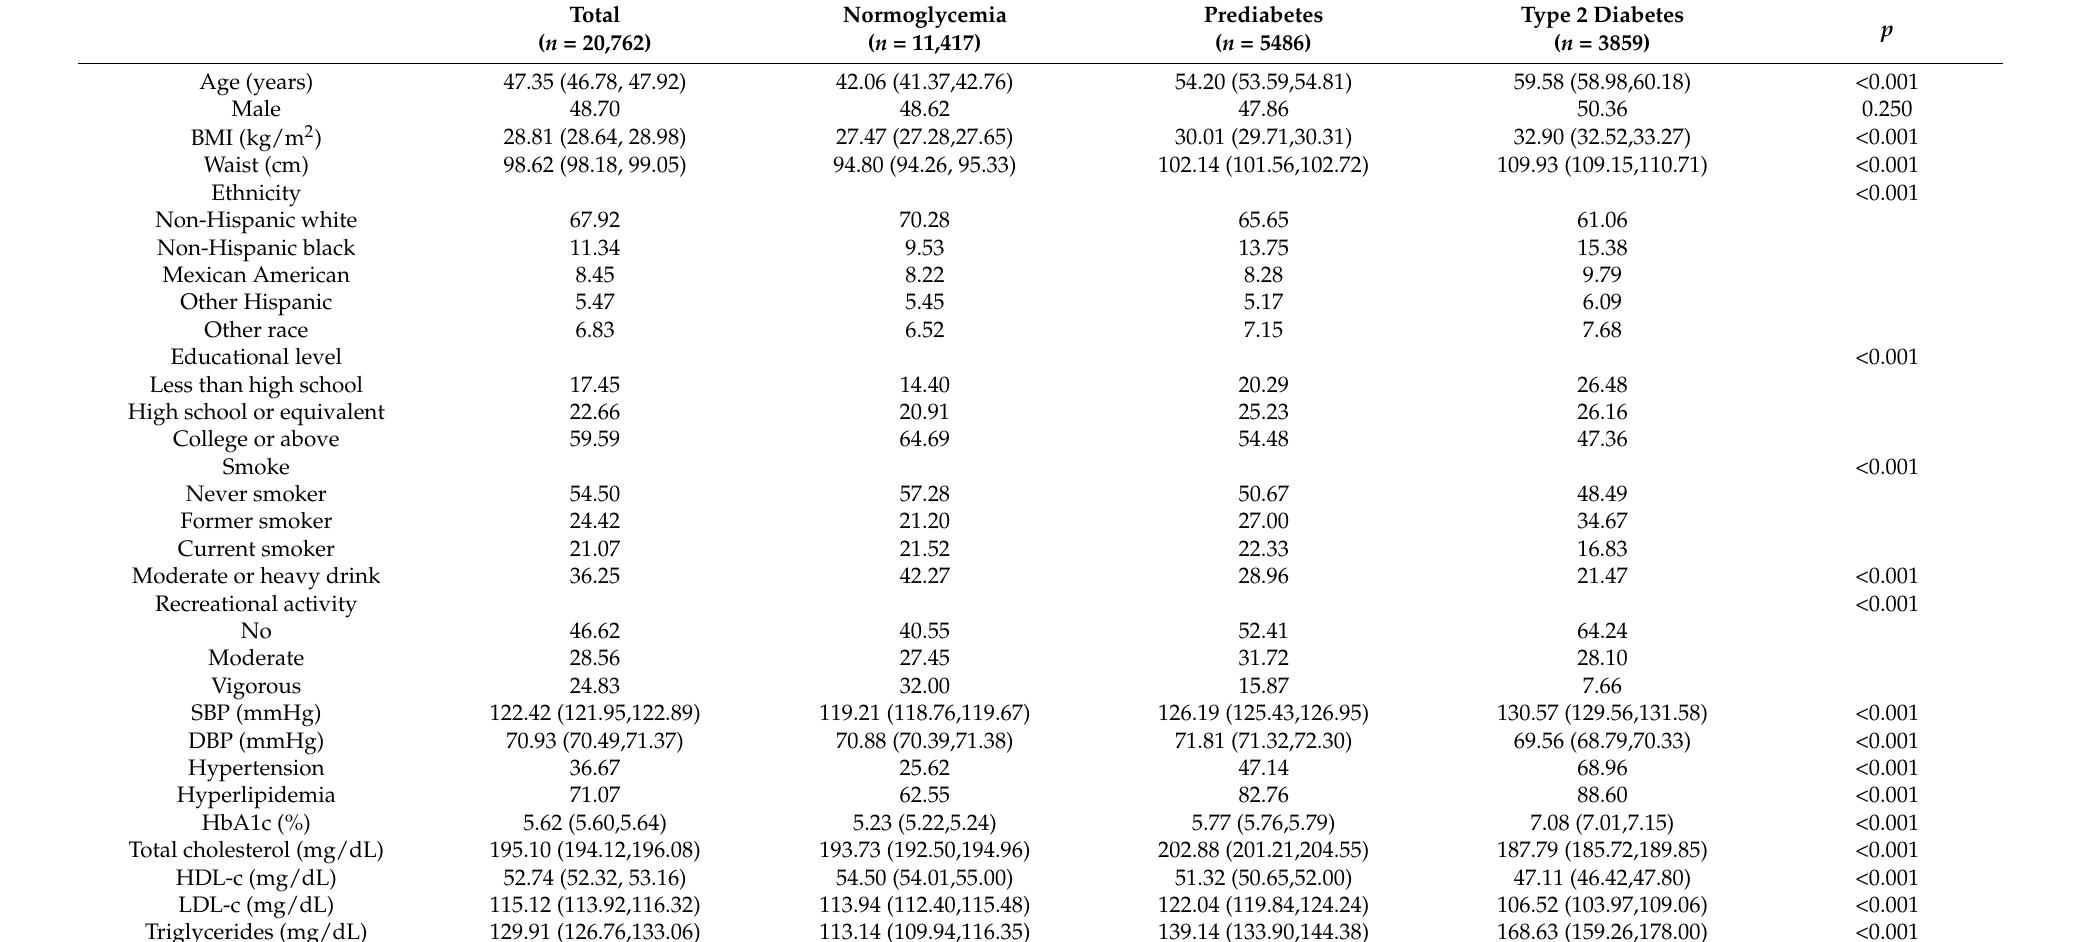
Table 1. Basic characteristics of participants by baseline glycemic